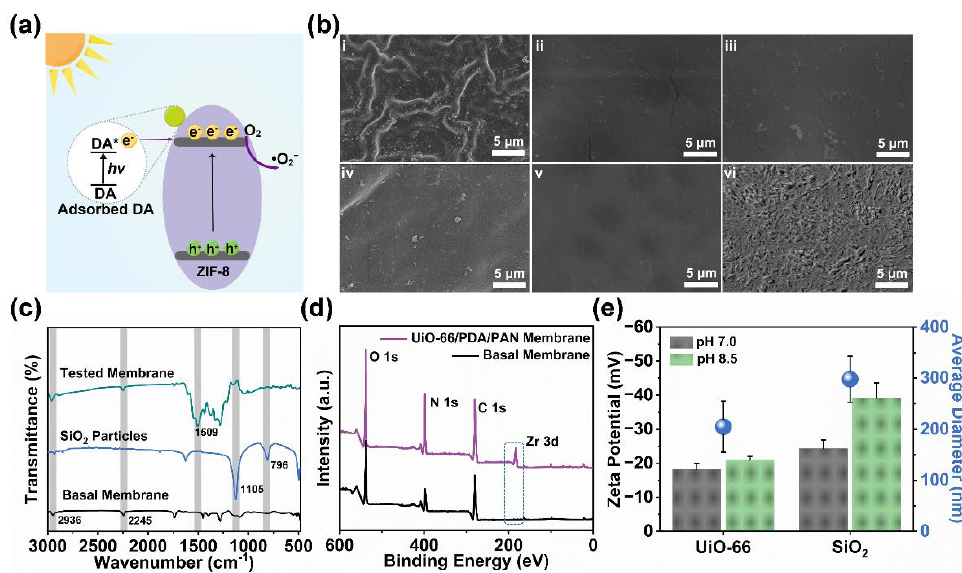
Figure 5. ( a ) Schematics of the co-operative deposition between ZIF-8 and DA; ( b ) SEM images of membranes under (i) UV irradiation, pH 7.0; (ii) dark, pH 7.0; (iii) visible light, pH 8.5; (iv) dark, pH 8.5; (v) visible light, pH 7.0, SiO 2 ; and (vi) visible light, pH 7.0, UiO-66; ( c ) zeta potential and average particle size diagram of SiO 2 and UiO-66 particles; ( d ) ATR–FTIR spectra of the SiO 2 particles assembled into the new basal membrane; ( e ) XPS spectra of the UiO-66 particles assembled into the new basal membrane.